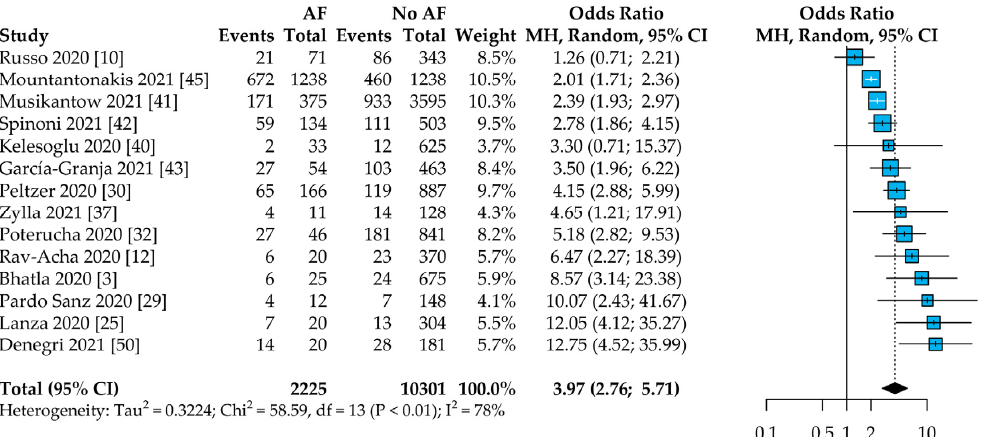
Figure 3. Risk of all-cause mortality in AF vs. non-AF patients. Legend: AF = atrial fibrillation; CI = confidence interval; MH = Mantel–Haenszel. Subgroup analyses according to the outcome definition are reported in Figure S4.